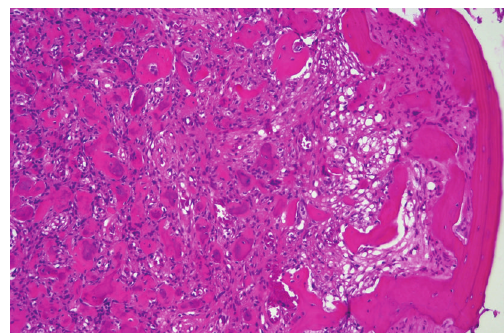
Figure 7: Chronic osteomyelitis. Parallel arrangement of lamellar bone trabeculae and intervening edematous marrow with sparse lymphocytes are typical for this disease.